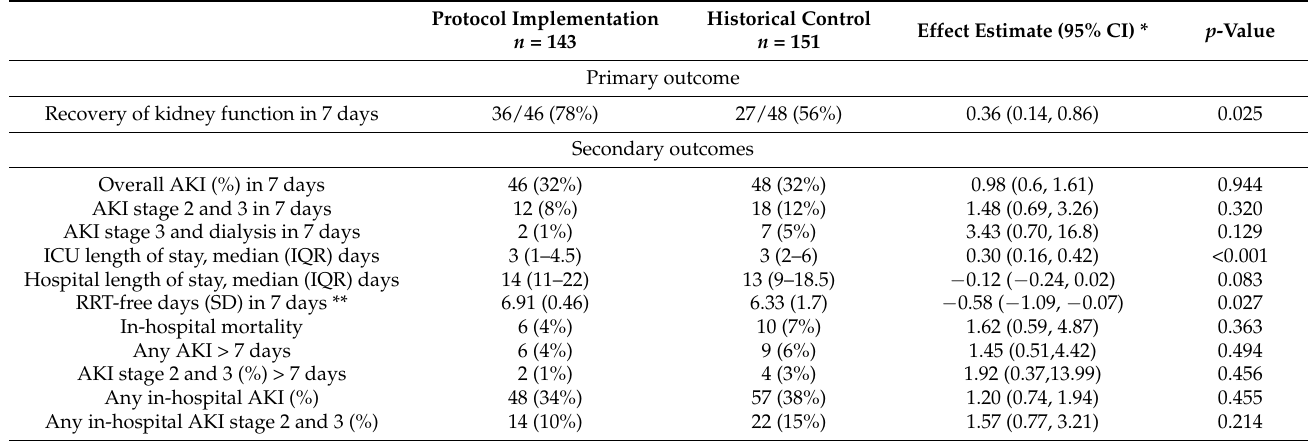
Table 3. Clinical outcome of protocol implementation group vs. historical control group.